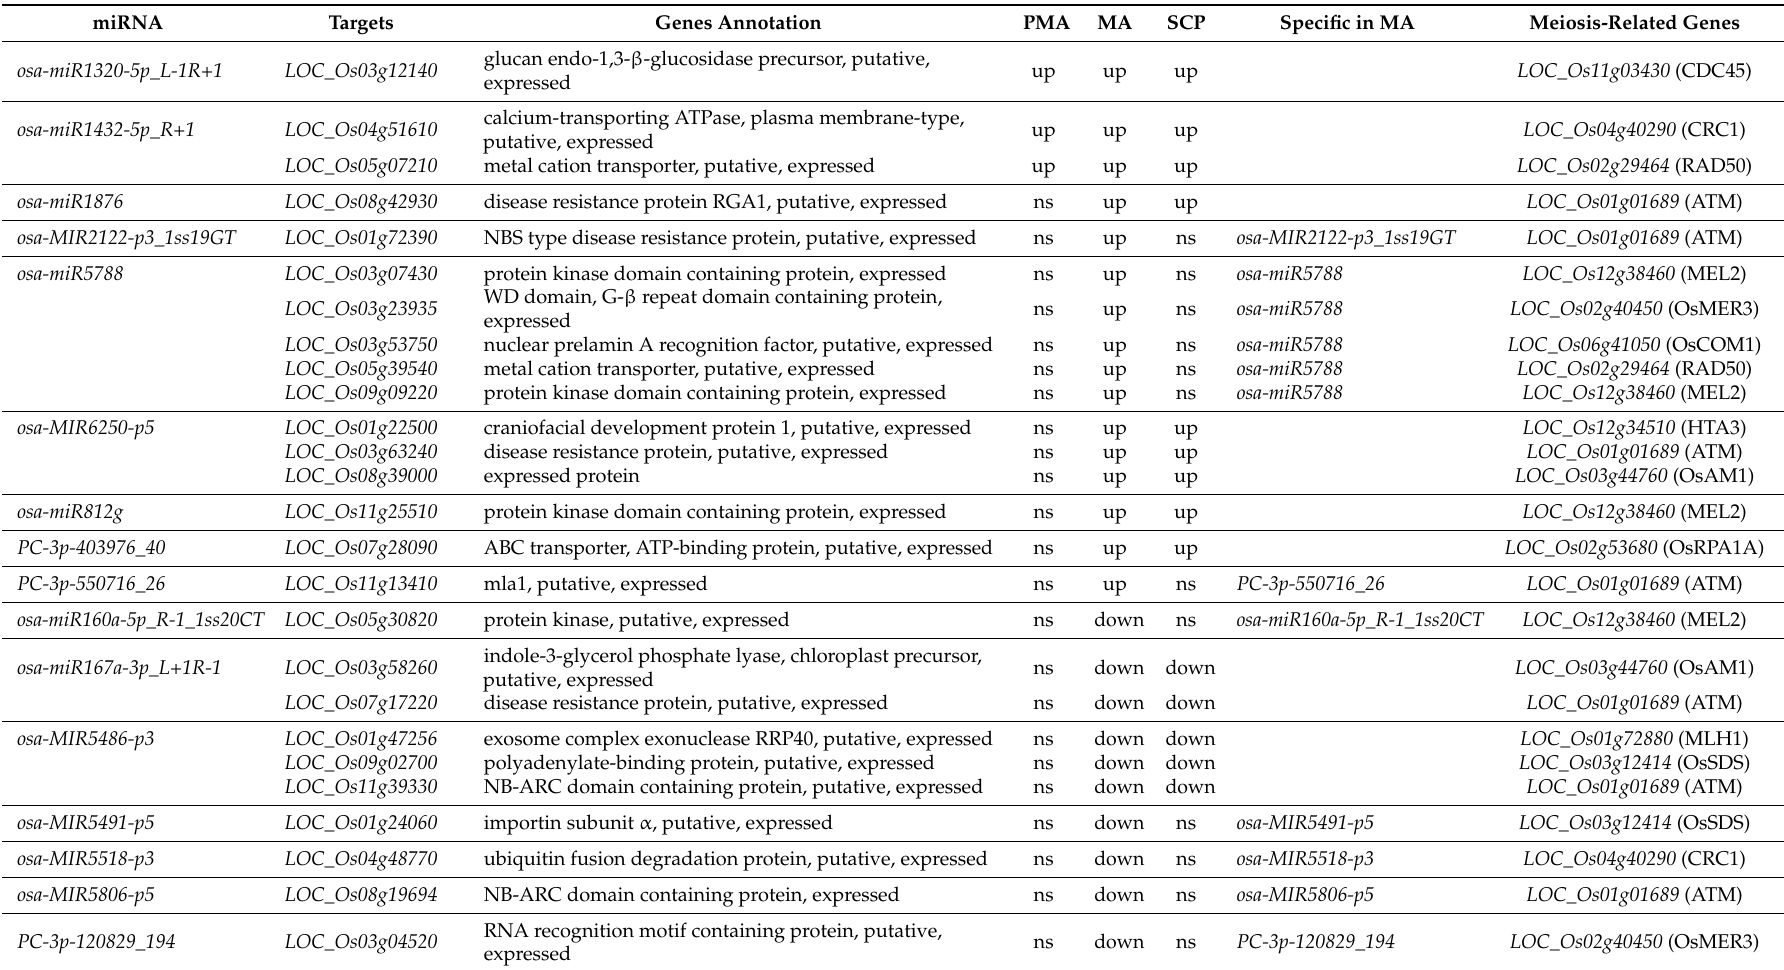
Table 2. Association between differentially expressed miRNAs (DEM) and meiosis-related genes in autotetraploid rice during pollen development. miRNA Targets Genes